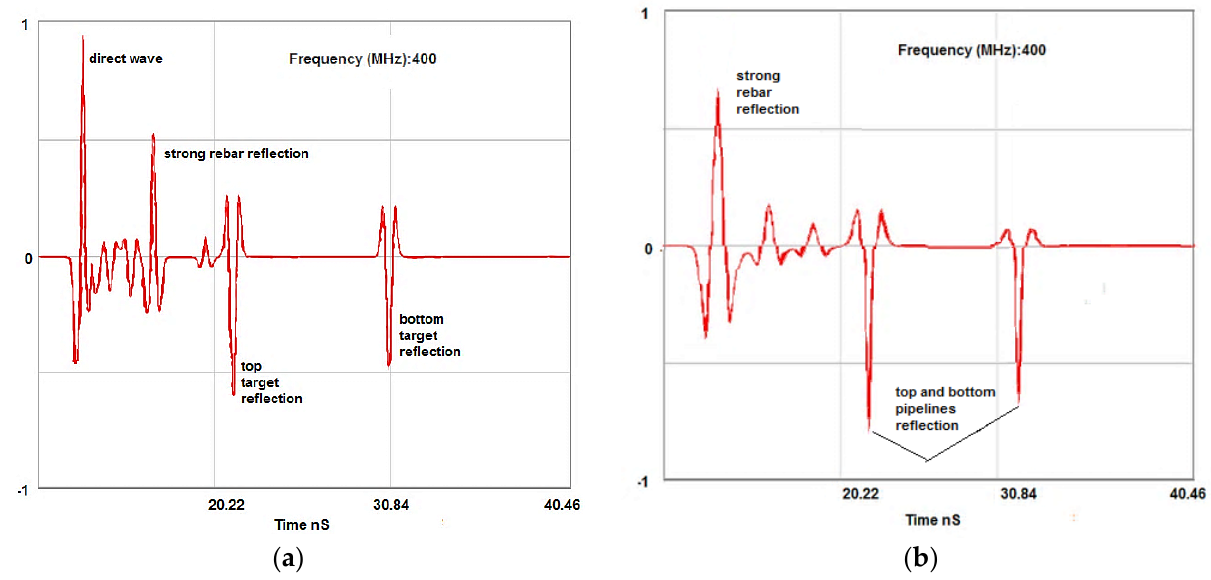
Figure 7. A-scan after filtering of raw experimental data delivered by GPR system: ( a ) original GPR record (raw data with direct wave); ( b ) after filtered signal (show both rebar and the pipelines